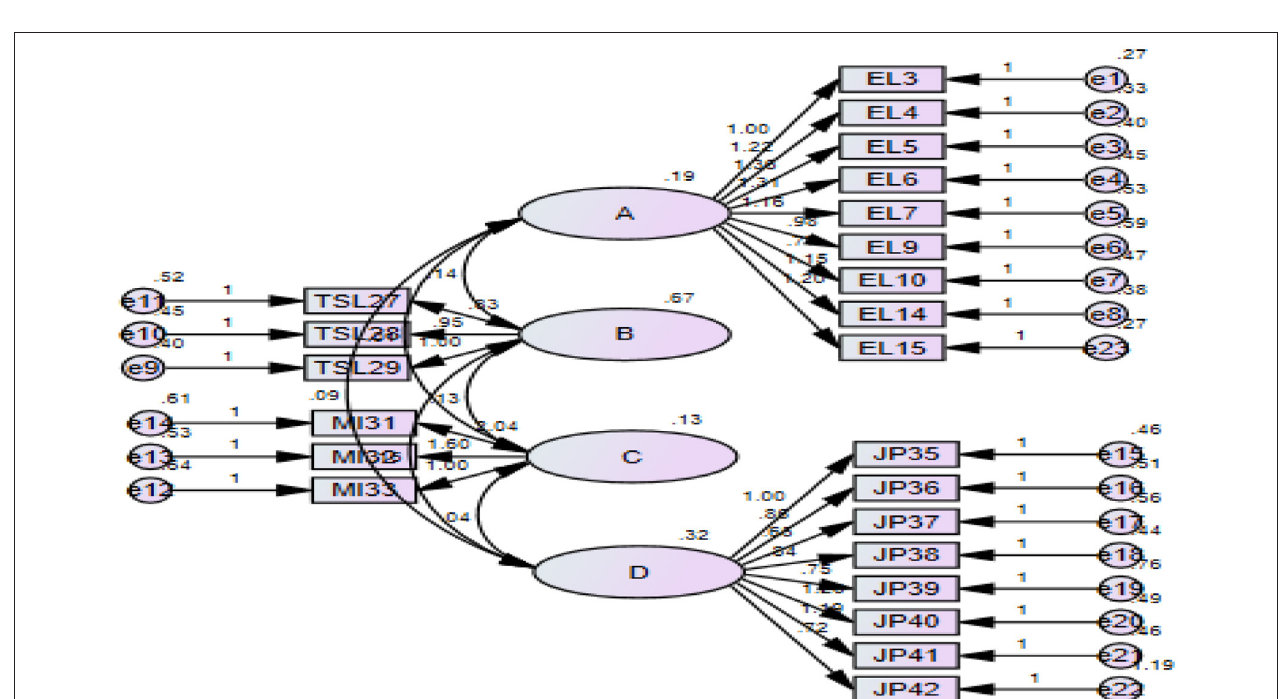
FIGURE 4 | CFA model.